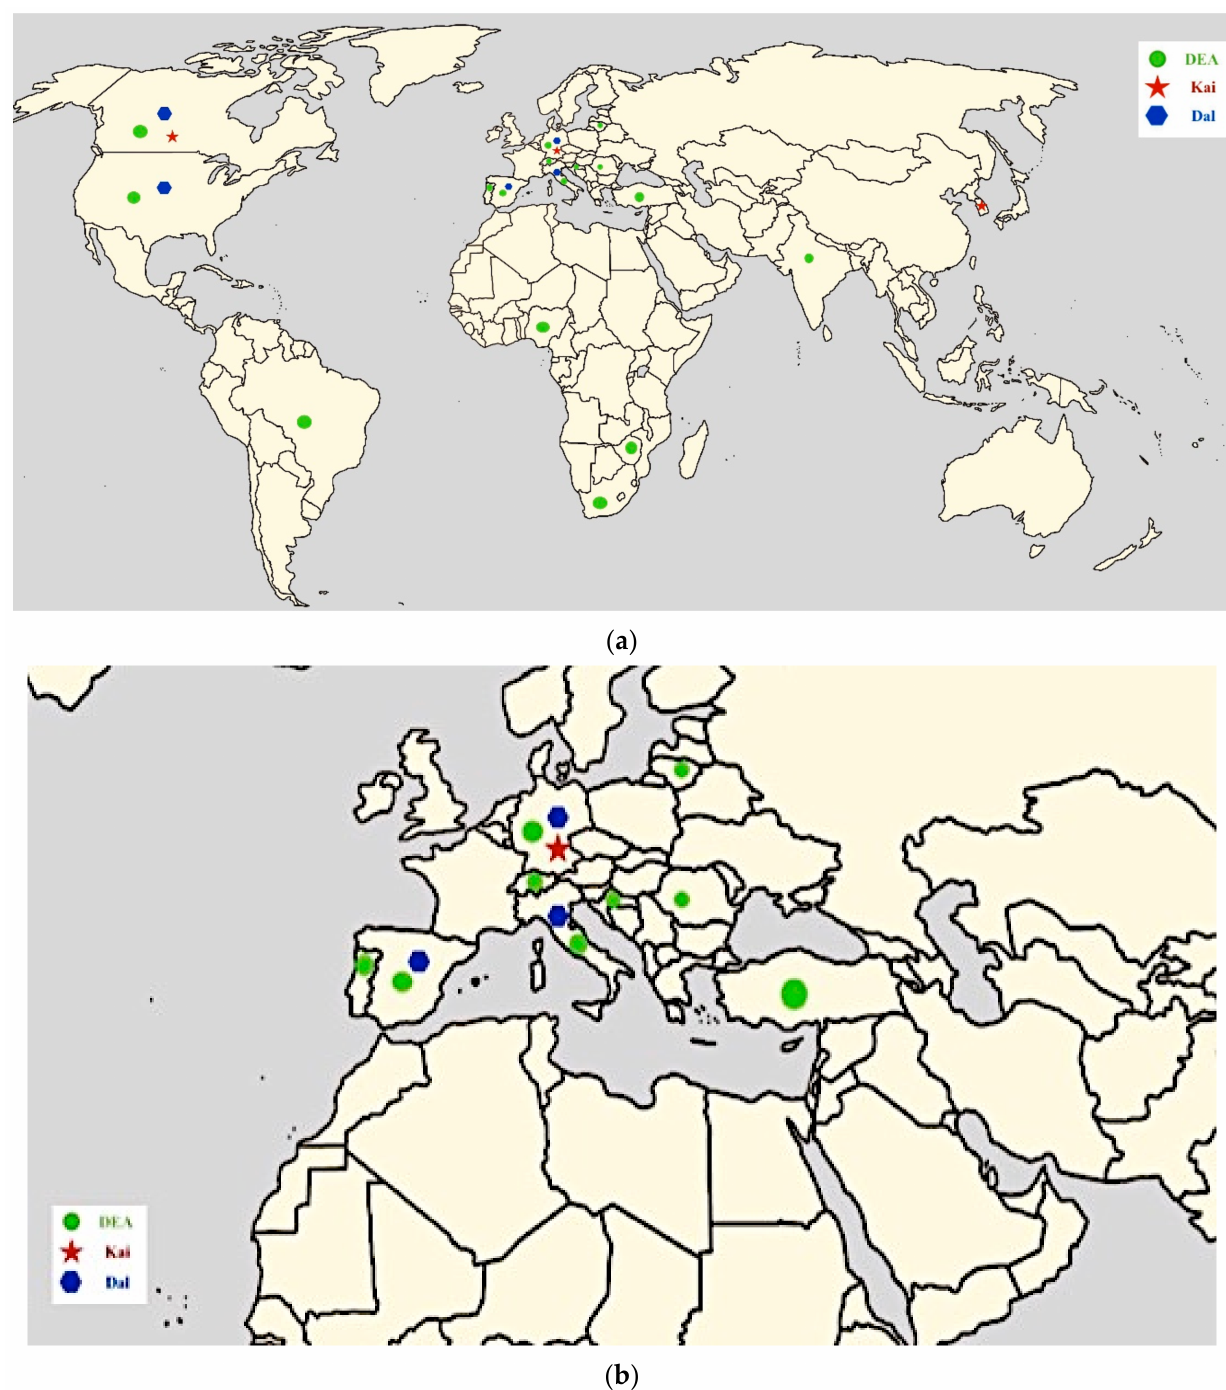
Figure 2. ( a ) A map showing the countries in the world where studies on the determination of dog blood groups (DEA, Kai, and Dal) were carried out; ( b ) A map showing the countries in central Europe where studies on the determination of dog blood groups (DEA, Kai, and Dal) were carried